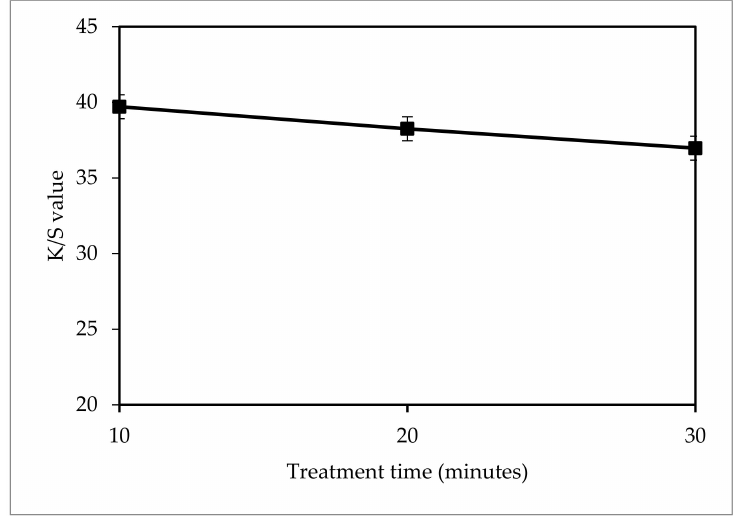
Figure 4. Effect of treatment time of plasma-induced ozone colour-fading effect on the sulphur-dyed knitted cotton